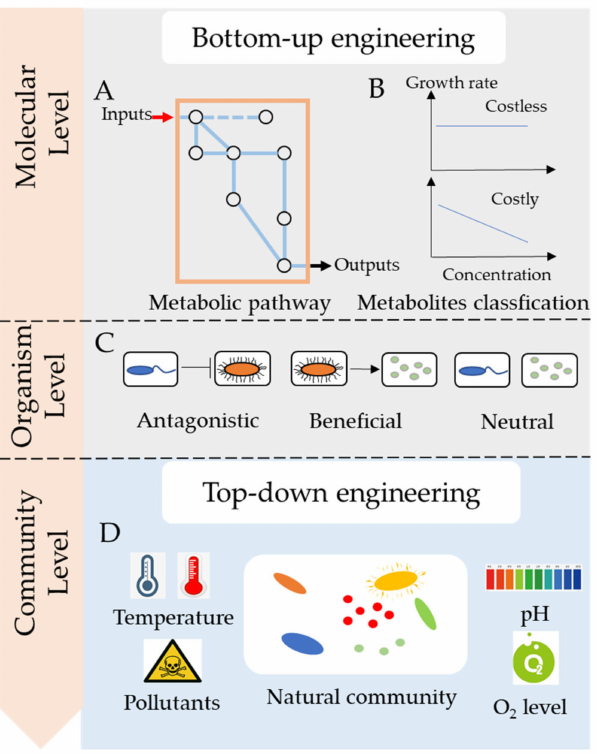
Figure 1. Approaches for engineering microbial consortia. There are two main approaches for engineering microbial consortia: bottom-up engineering and top-down engineering. Bottom-up engineering involves reconfiguring the metabolic pathway ( A ) and reprogramming social interac- tions (choose the species without reprogramming their metabolism). ( C ) The interactions between microbial consortia include antagonistic, neutral, or beneficial interactions ( B ) Metabolites are mainly divided into costless and costly depending on whether the secretion of metabolites causes a loss to fitness in monoculture (represented by growth rate). ( D ) Top-down engineering involves compelling a natural microbial community to perform desired functions by modifying environmental variables, such as temperature, pH, salt content, redox conditions, and carbon